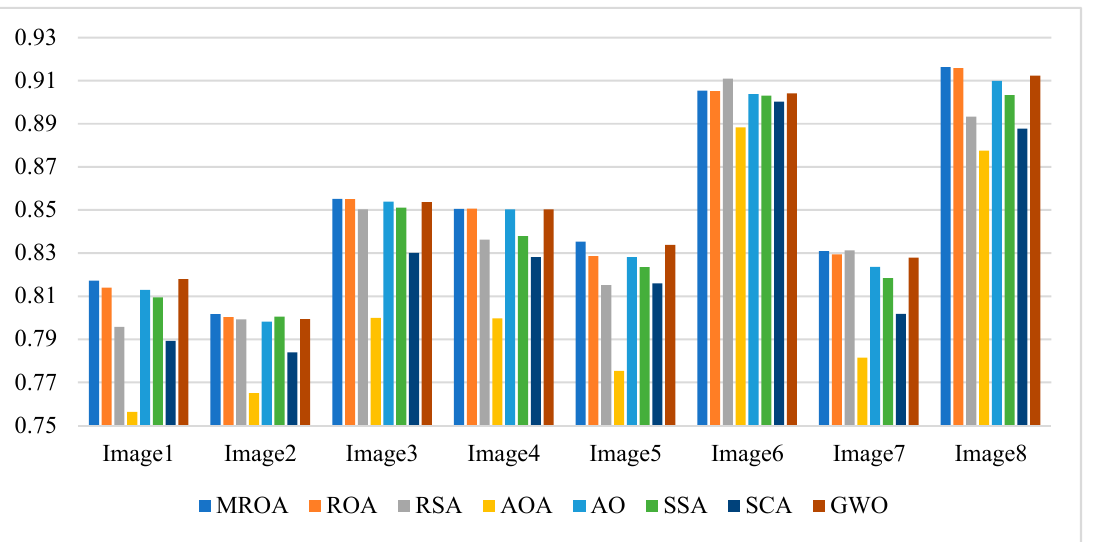
Figure 11. Average PSNR values obtained by the algorithms over all images.